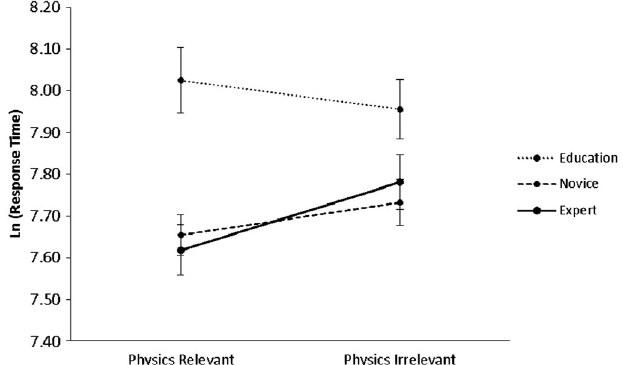
FIG. 1. Mean adjusted Ln (Response Time) for experts, novices, and education participants.